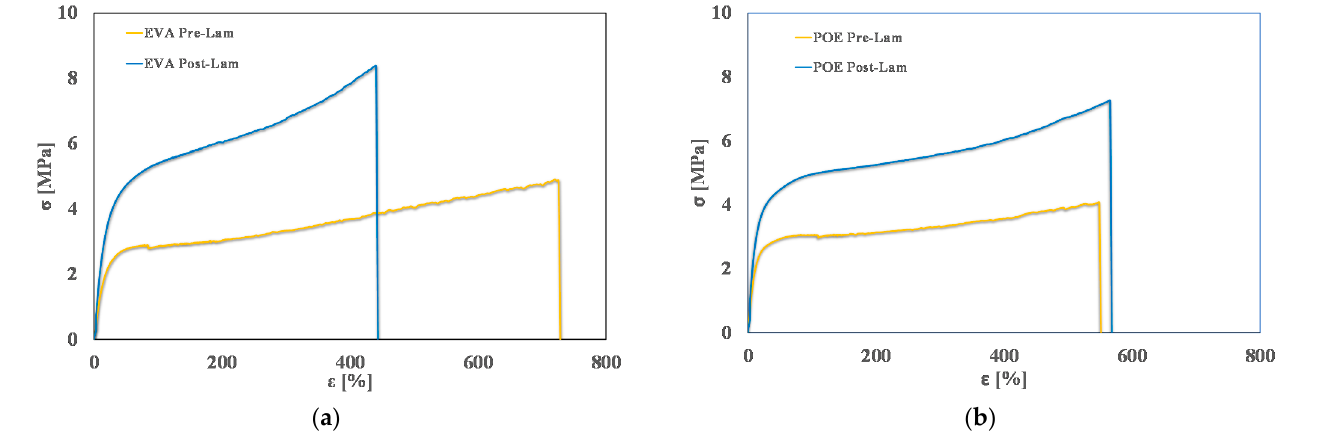
Figure 4. Stress-strain curves of ( a ) EVApre-lam and EVApost-lam and ( b ) POEpre-lam and POEpost-lam commercial samples. Table 2. Main mechanical properties, i.e., elastic modulus (E), tensile strength (TS) and elongation at break (EB) of pre-laminated and post-laminated EVA and POE